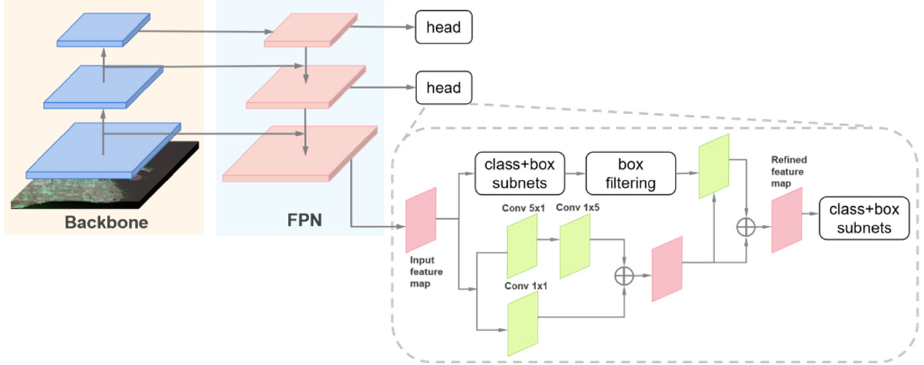
Figure 10. The general architecture of Refined Rotation RetinaNet Detector (R 3 Det). The detection head including a feature refinement module and prediction subnets.